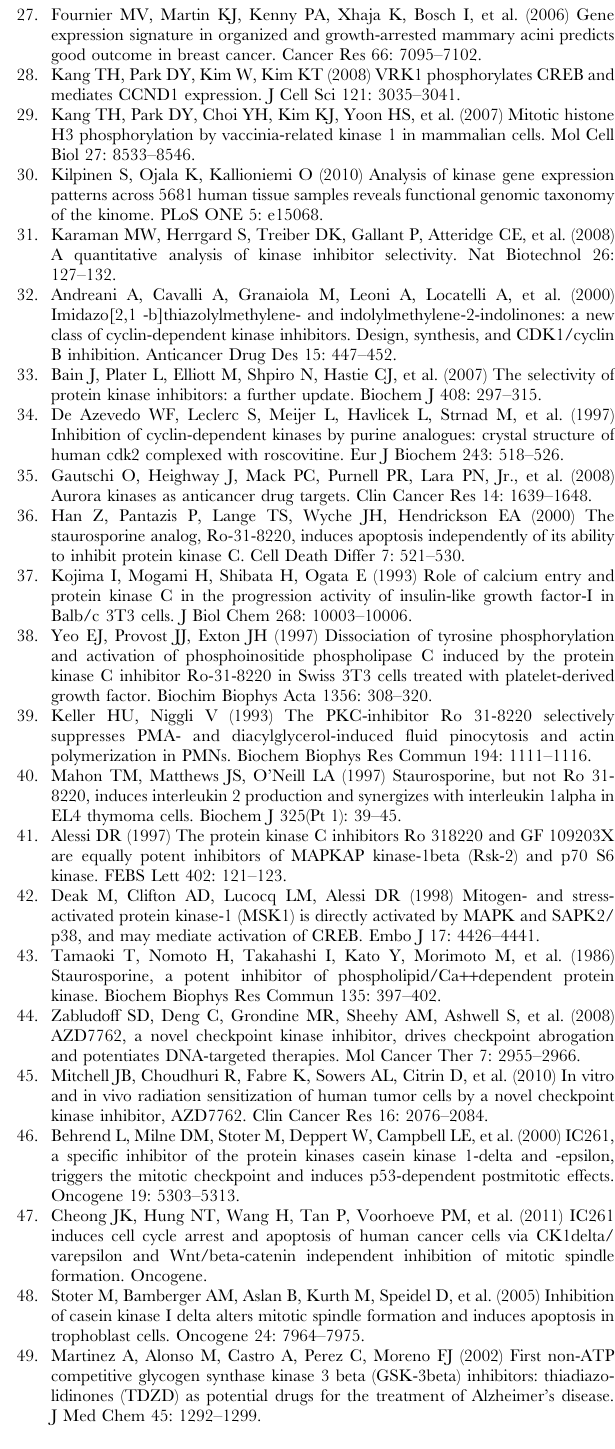
Table S1 Inhibitors of serine-threonine